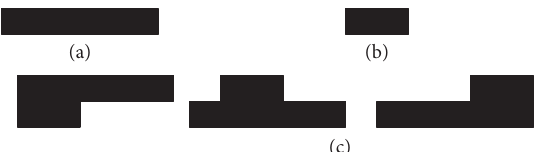
Figure 1: Schematic diagram of linear features and linear feature